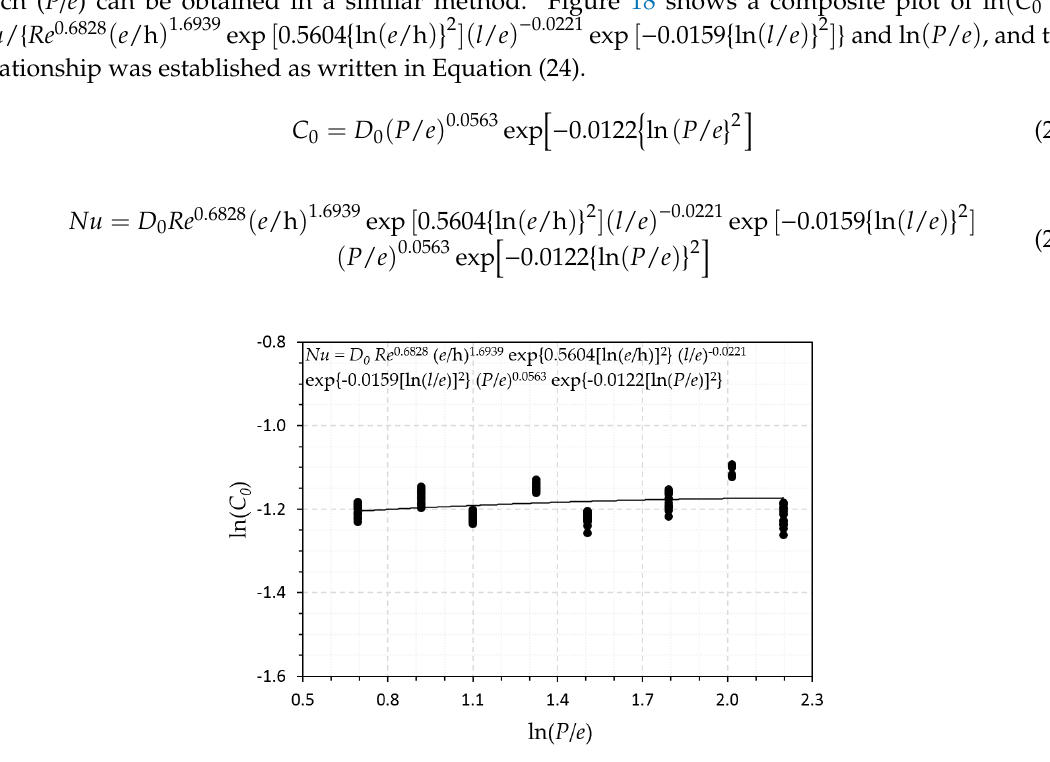
Figure 19. Comparison of simulation and predicted values of Nusselt number.